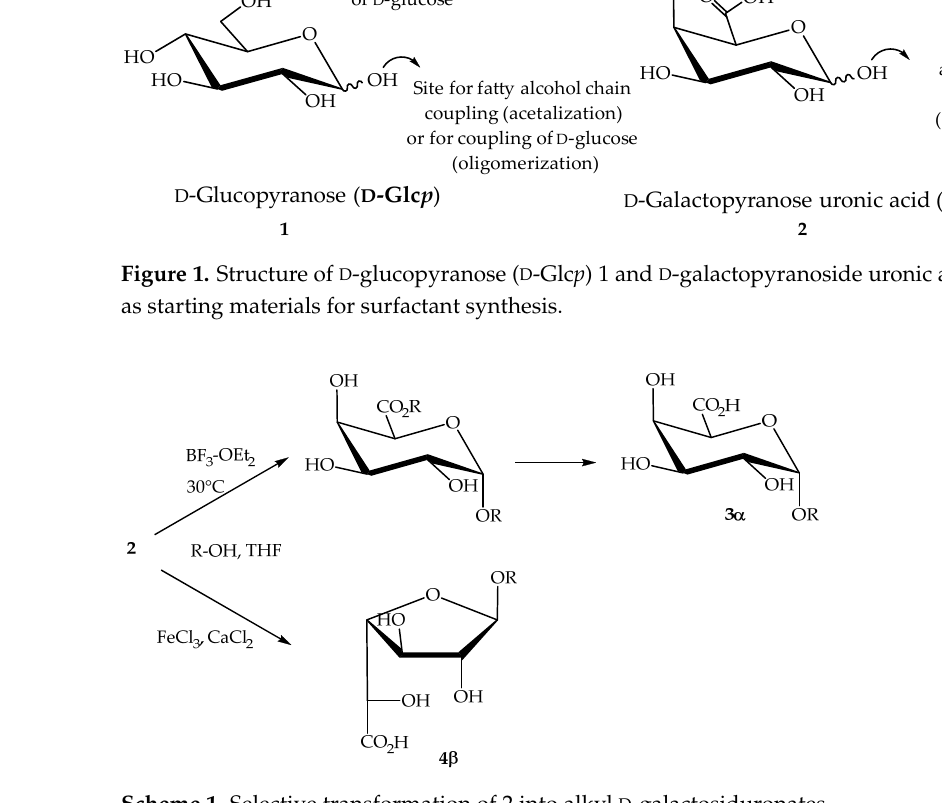
Figure 1. Structure of D -glucopyranose ( D -Glc p ) 1 and D -galactopyranoside uronic acid ( D -Gal p A ) 2 as starting materials for surfactant